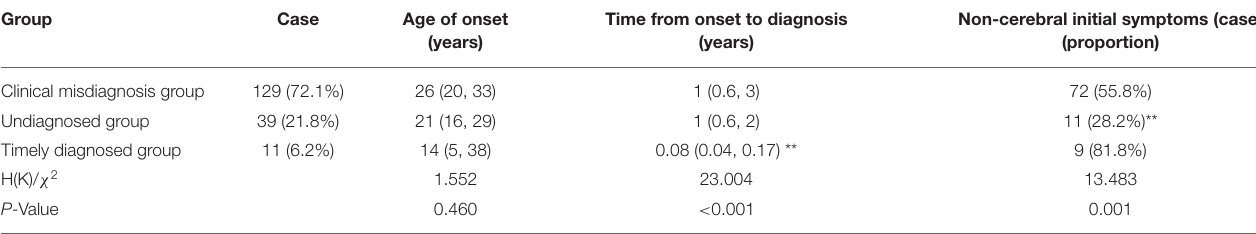
Non-cerebral initial symptoms (case) (years) (proportion)